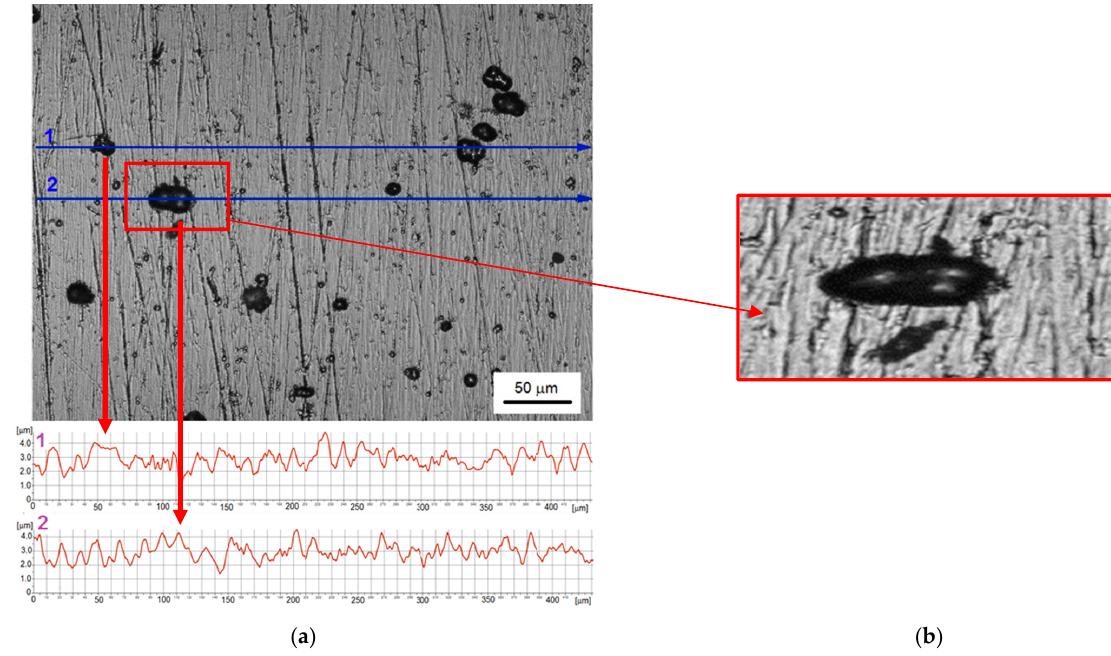
Figure 2. Nickel coating before cavitation erosion tests: ( a ) surface morphology with roughness profiles along the selected measurement lines; ( b ) 3D profile of a surface defect.